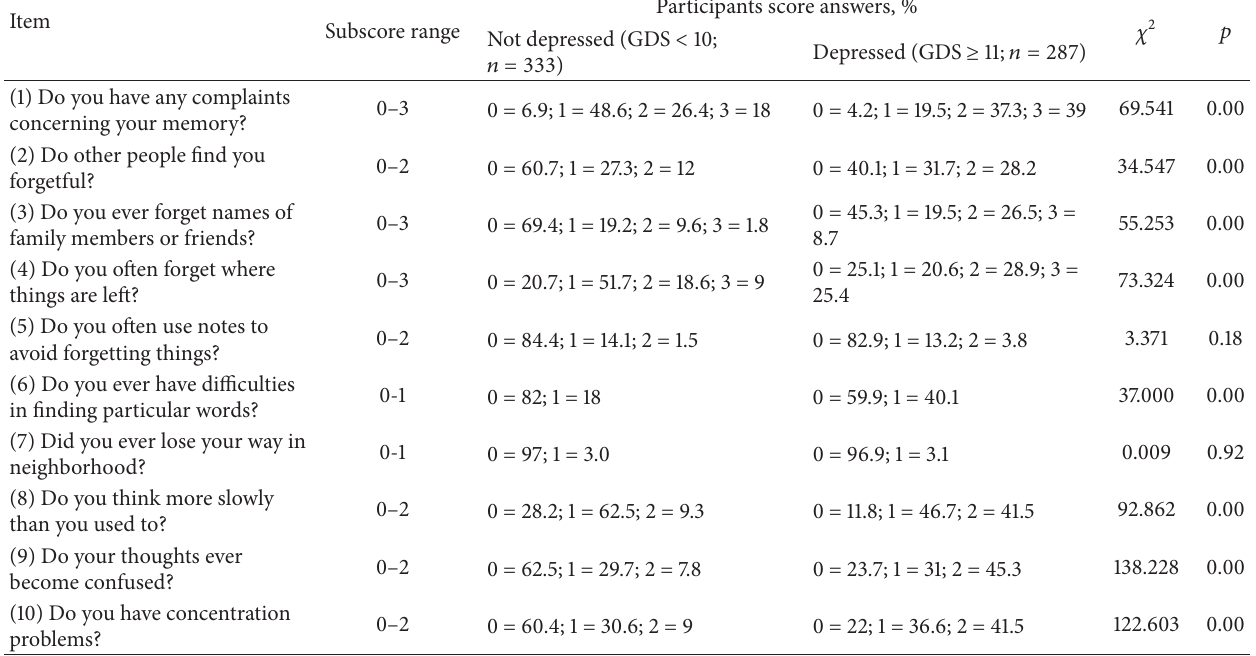
Table 2: Results of the QSM.